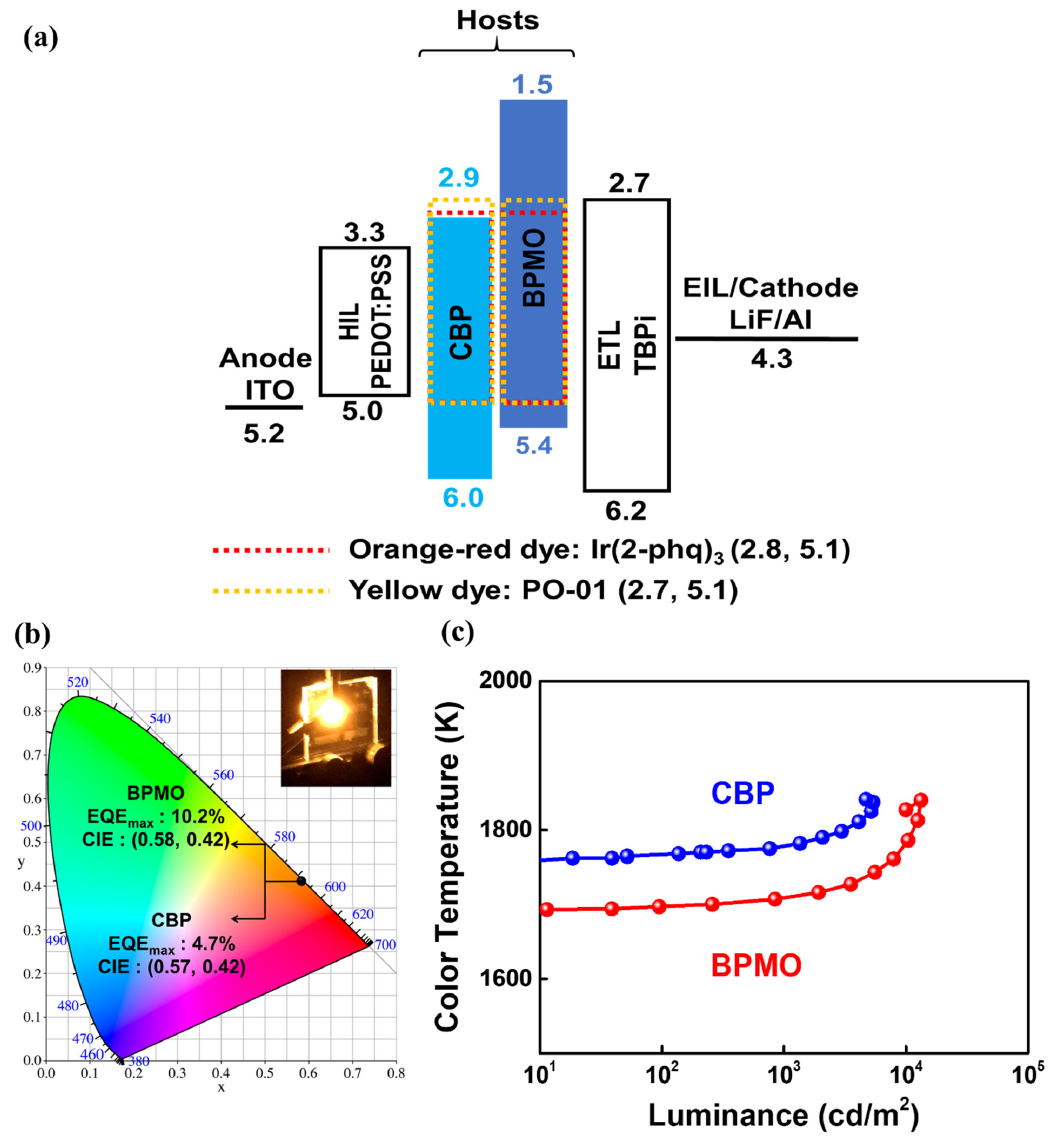
Figure 4. BPMO- and CBP-based candlelight organic LED showing ( a ) schematic energy level diagram using emitters PO-01 (yellow) and Ir(2-phq) 3 (orange-red), ( b ) CIE chromaticity with achieved maximum EQE and device pixel image (inset figure), and ( c ) color-temperature variation with luminance.